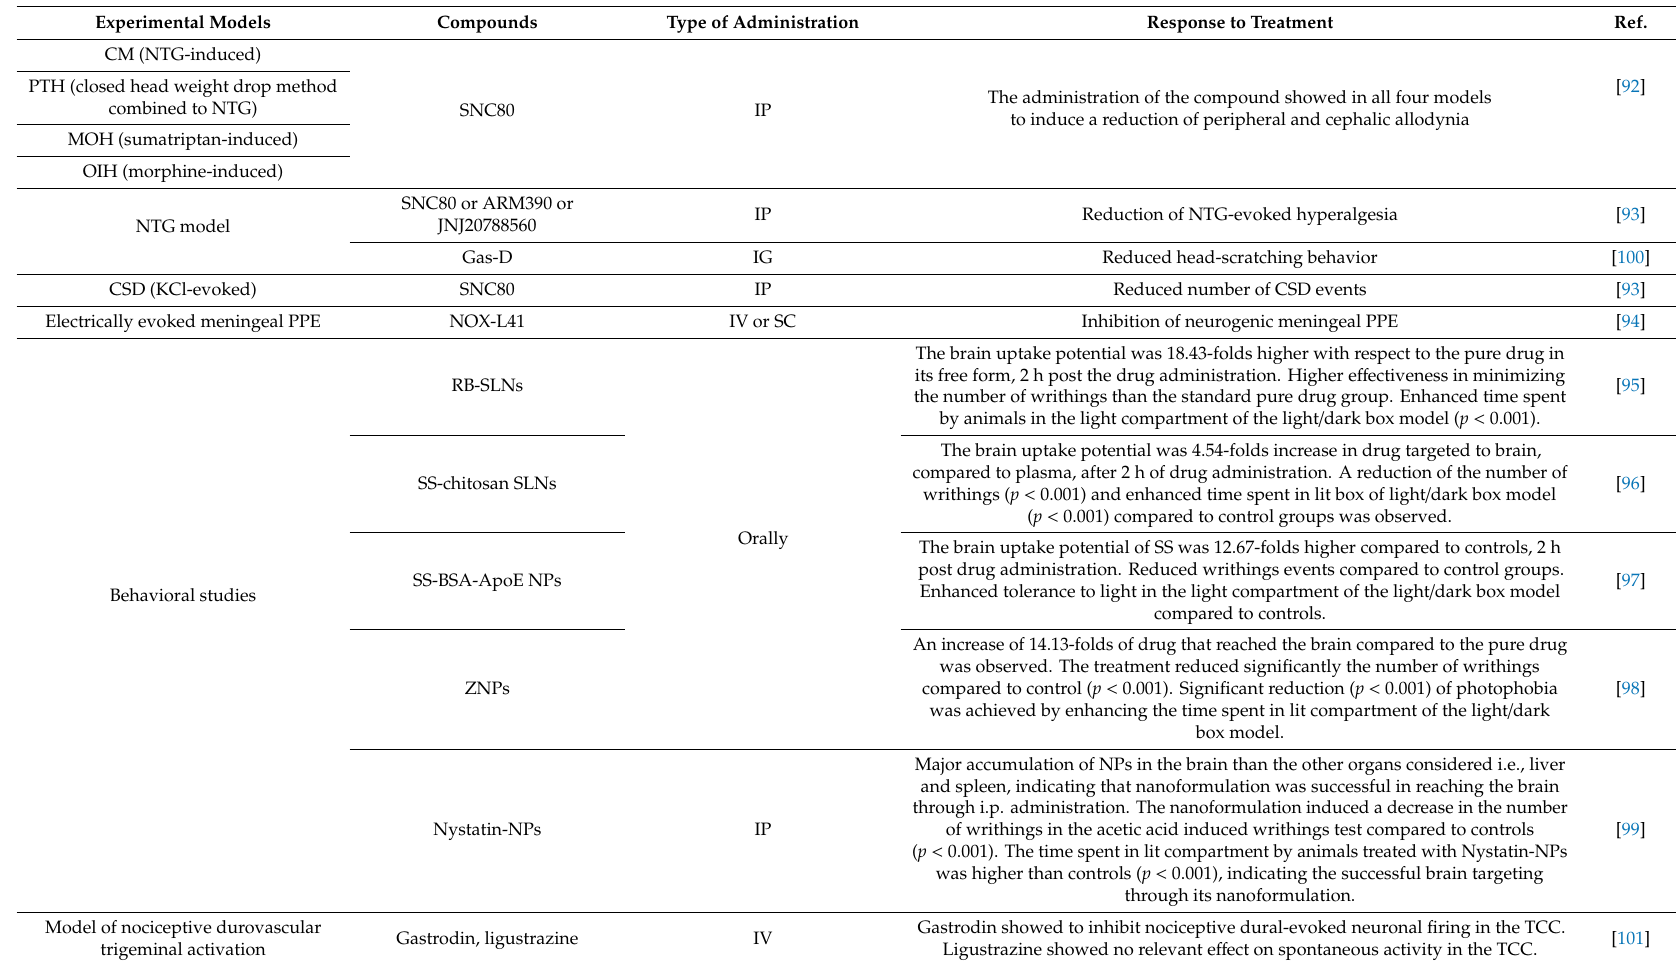
Table 4. New compounds and nanoparticles in experimental